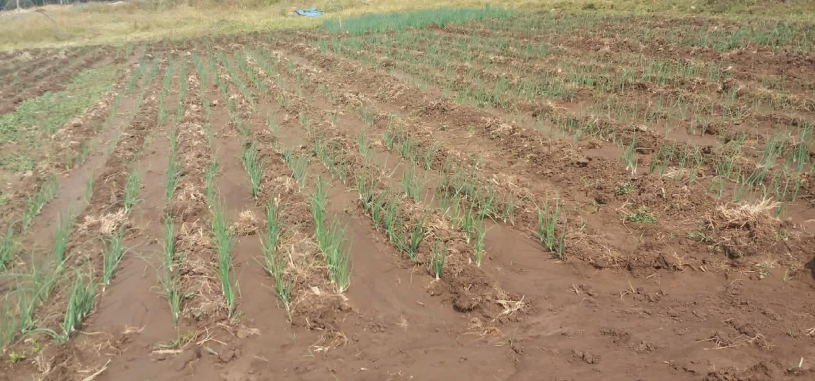
Figure 3: Vegetative growth of onion at the early stage of development.